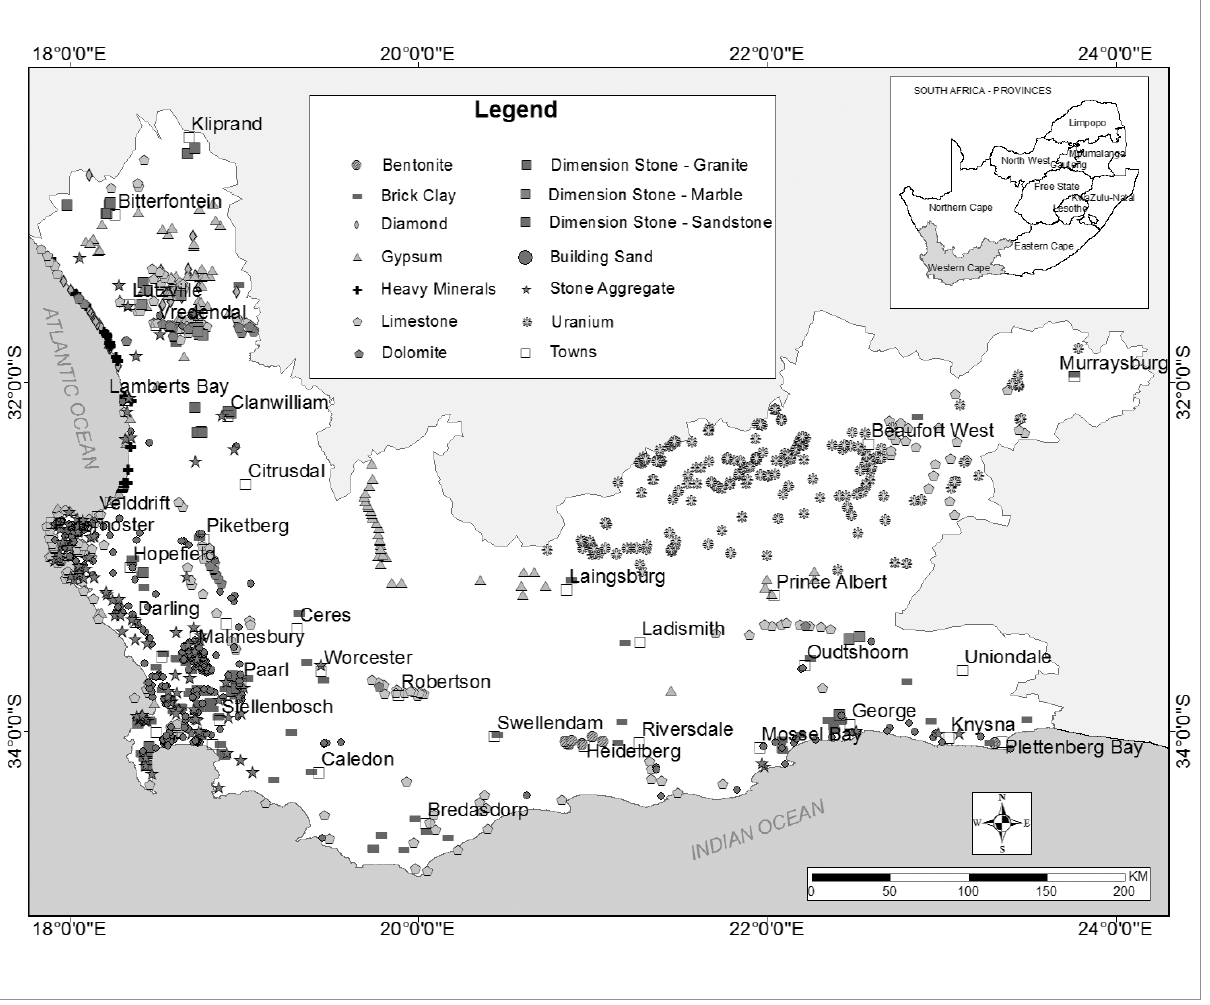
Figure 2: Map of the mineral potential of the Western Cape